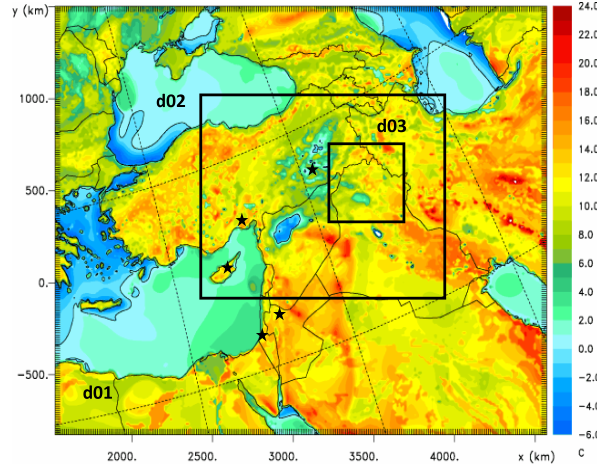
Figure 1. Modelling domain structure and difference ( ◦ C) between model soil temperature and model temperature at 2m, 10:00UTC, on 6 September 2015. The black rectangles indicate the location of the nested model domains (d01: 12 × 12km; d02: 4 × 4km; d03: 2 × 2km), and black stars indicate the locations of